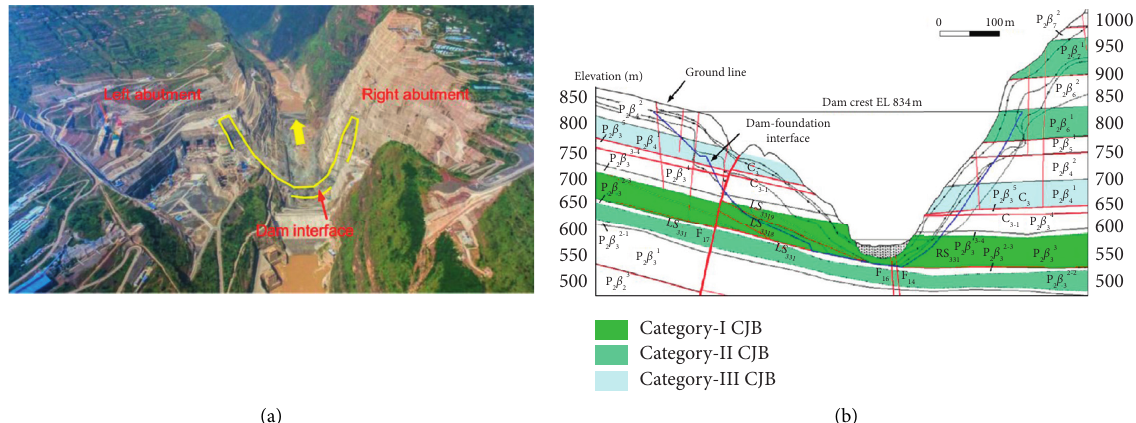
Figure 1: Topographical and geological conditions of Baihetan arch dam: (a) topographical conditions at the dam site; (b) geological profile along the dam axis [2, 34].